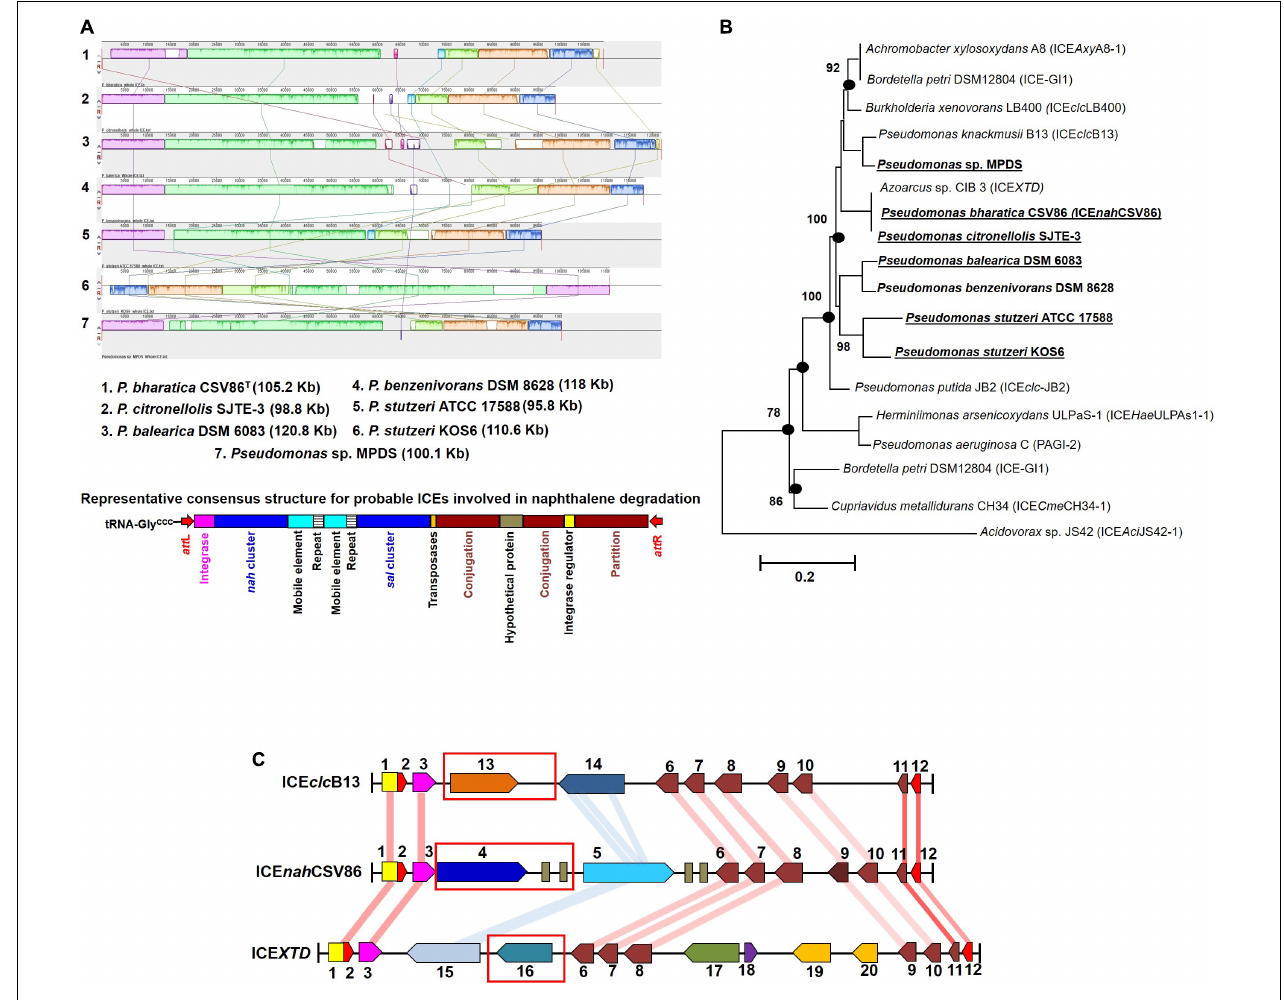
FIGURE 4 | Comparative-functional genomic analyses of nah - sal clusters including adjacent up/down-stream sequences from various naphthalene/aromatic degrading Pseudomonas spp. (A) Synteny mapping of probable ICEs harboring nah - sal clusters and its comparison with ICE nah CSV86. The representative consensus structure for all naphthalene degradation encoding probable ICEs has been depicted at the bottom of the synteny plot. (B) ML phylogenetic analysis of ICE nah CSV86 with probable ICEs, belonging to the ICE clc family, from naphthalene and aromatic degrading bacteria. Taxa in bold indicate the probable naphthalene degrading bacteria while bold with underline indicate reported naphthalene utilization/degradation phenotype. Black dots at each node represent robustness of clade formed in all tree-making algorithms. Values near each branch of the phylogenetic tree indicate percent bootstrap re-iteration and bar below the trees indicate substitution (0.1–0.2%). (C) Artemis comparison-based synteny mapping of prototypical ICE nah CSV86 and its phylogenetically related neighbors (ICE clc B13 and ICE XTD ). The connecting lines between LCBs indicate percent similarity between various modules: blue ( < 60%), light red (60–70%), and deep red ( > 70%). Rectangular red boxes represent the upper pathway cargo modules of the respective